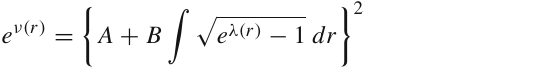
Fig. 3 Anisotropic factor (above) and adiabatic index (below) vs the radialcoordinate r correspondingtonumericalvaluesofconstantsgiven in Table 2 for four well-known compact stars